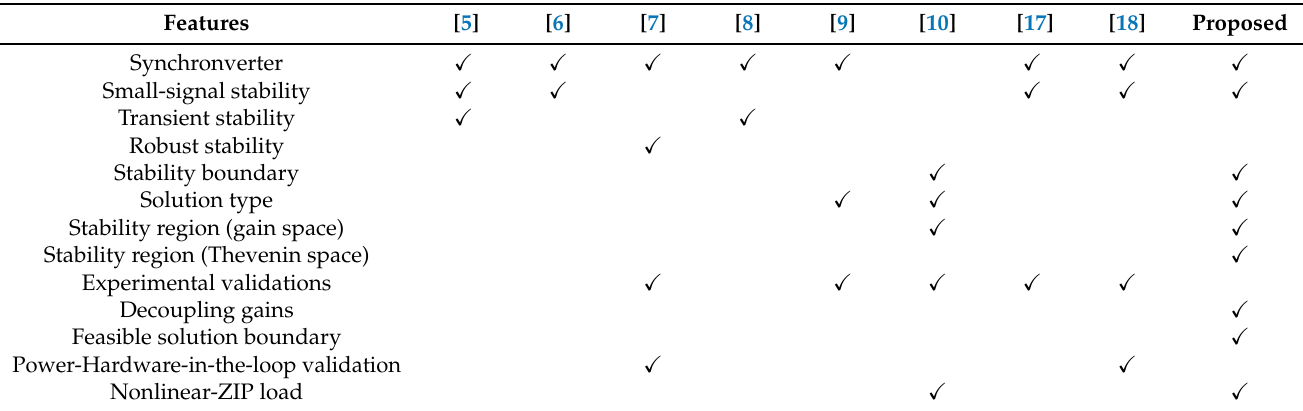
Table 1. Stability analysis in previous